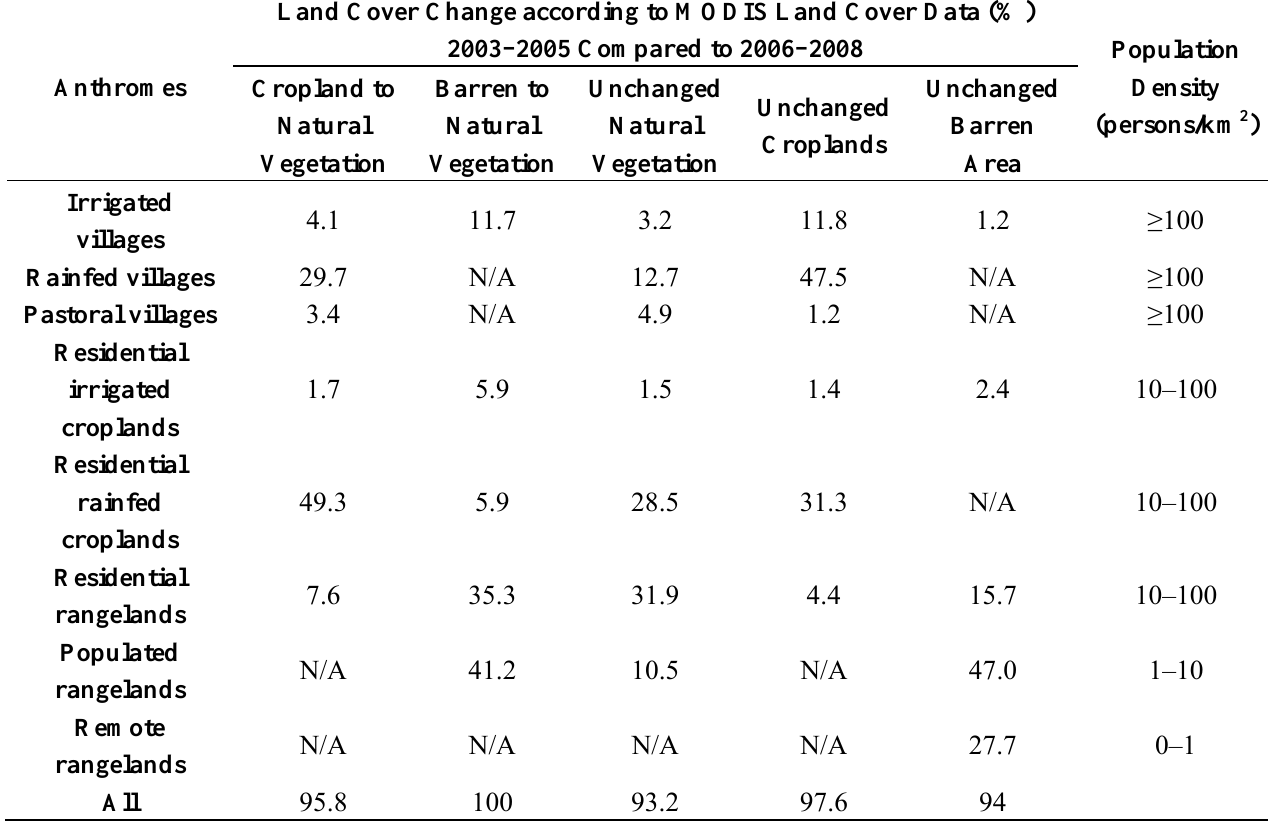
Table 4. Distribution of land cover changes in major anthromes within the area of positive vegetation